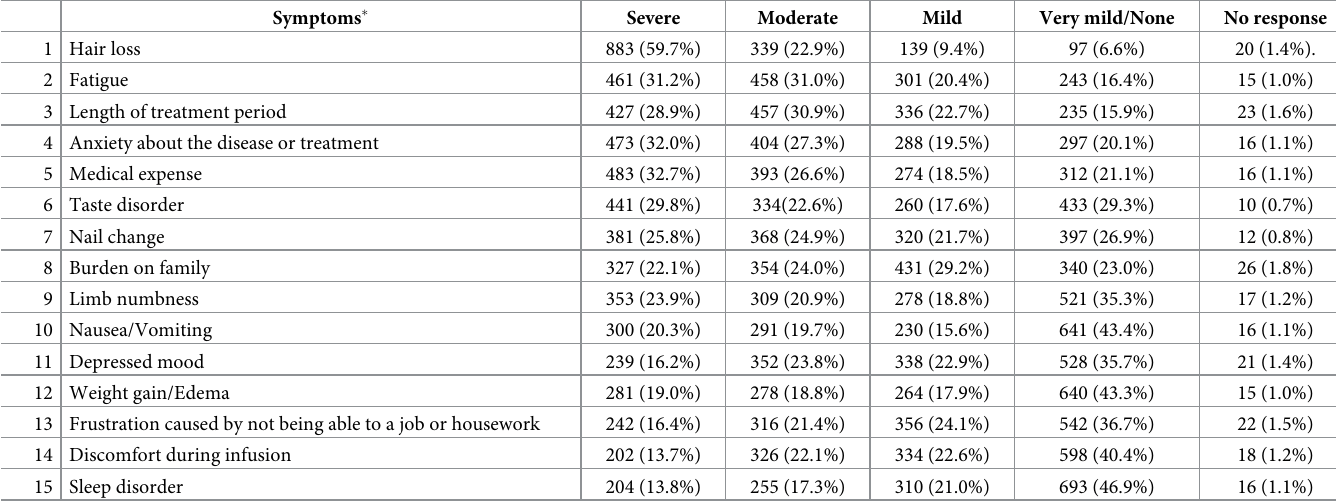
Table 2. Impact of side effects of chemotherapy.